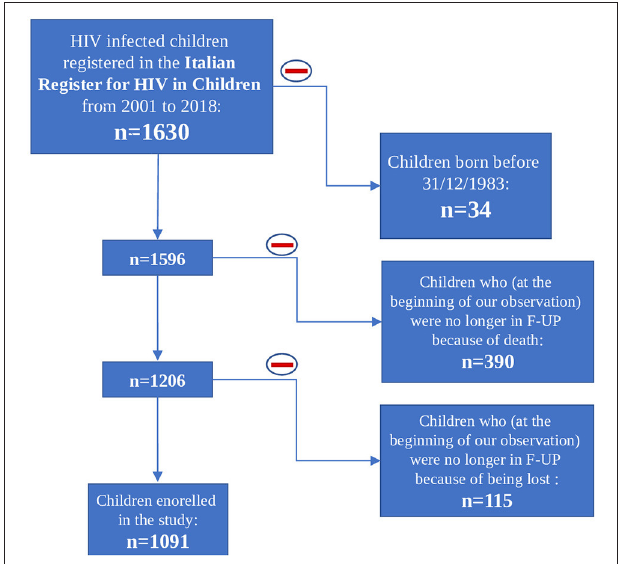
FIGURE 1 | Children included and excluded from the study population.